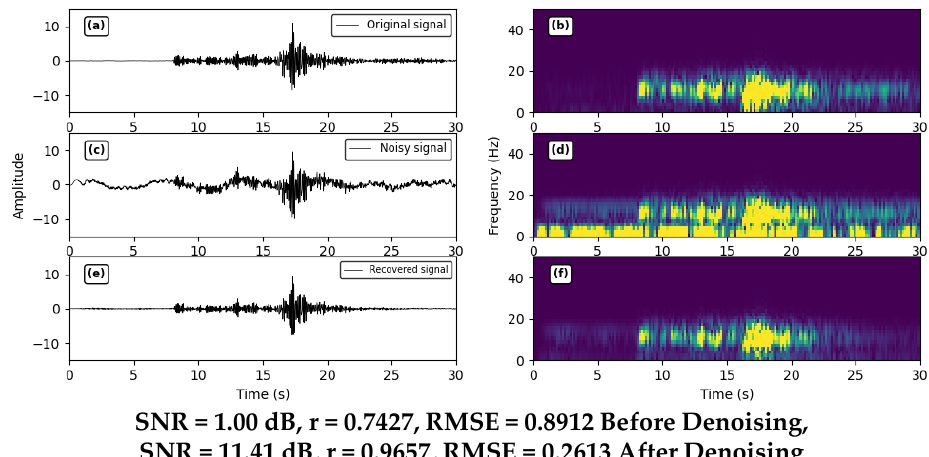
Figure 9. Co-band denoising of low-frequency noise and seismic signals.